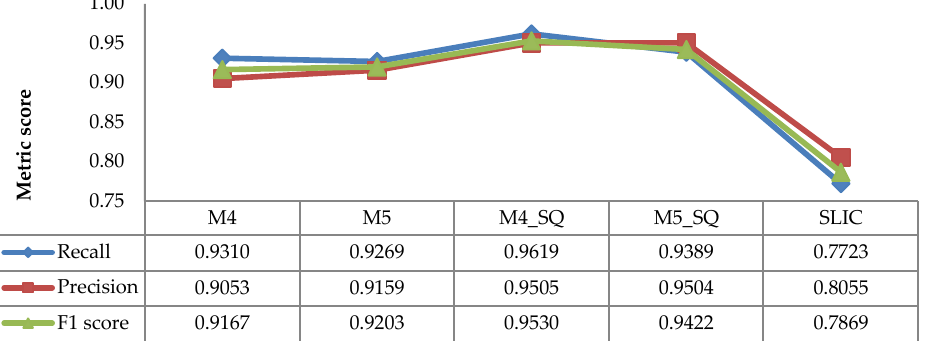
Figure 13. Average recall, precision, and F1 scores of the static image and image sequence methods.